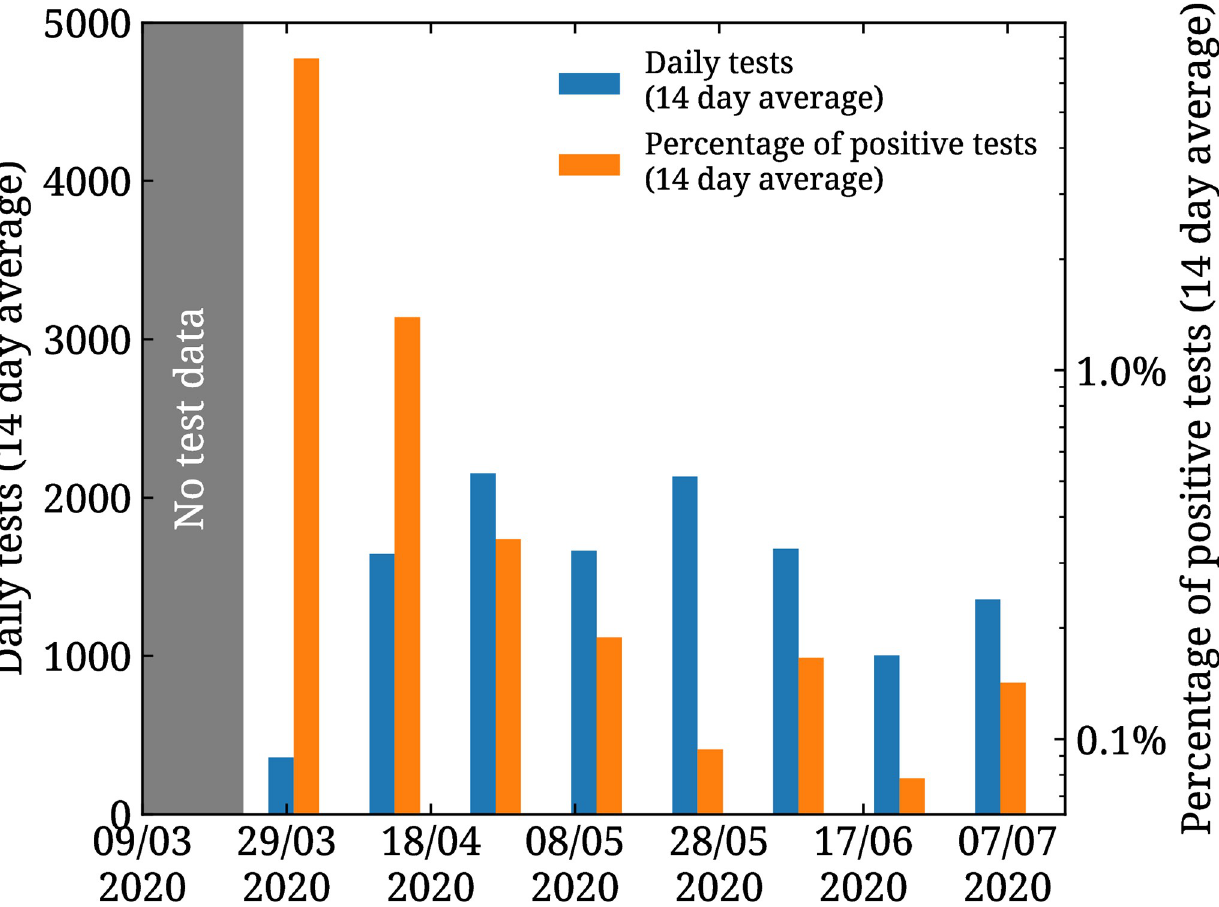
Fig 4. Daily tests and positivity rate in Cyprus. 14-day average of the daily tests (blue bars) and of the percentage of daily tests returned positive (orange bars) for Cyprus. The former is plotted on the left vertical axis while the latter on the right vertical axis.